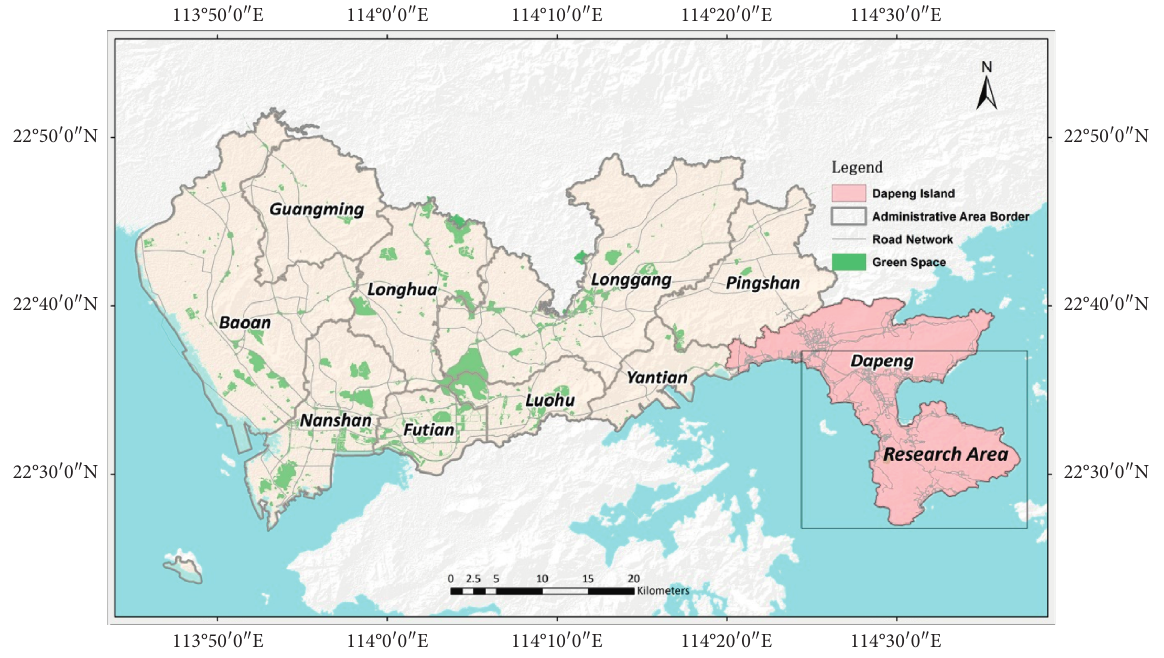
Figure 1: The location of dapeng island, Shenzhen.